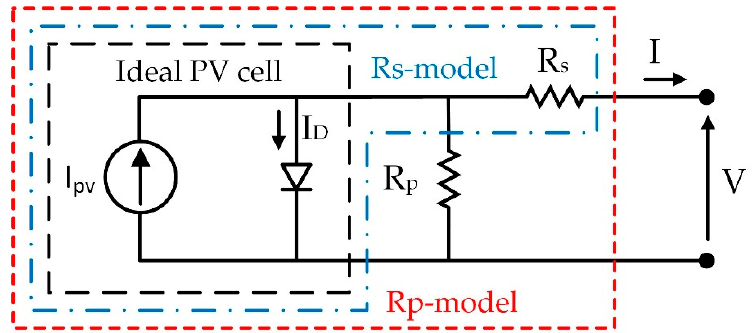
Figure 1. The single-diode model of the PV cell. Ideal PV cell (black dashed frame), Rs-model (blue dash-dotted frame) and Rp-model (red dashed frame).